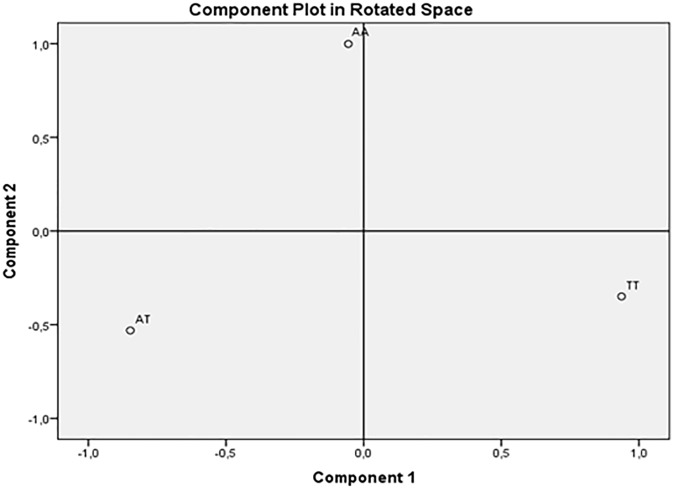
Component Plot in Rotated Space.